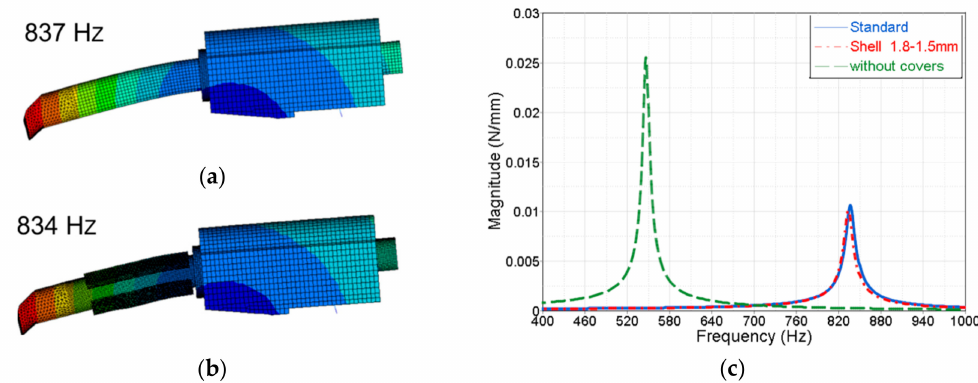
Figure 17. ( a ) Original boring bar dominant mode, ( b ) active boring bar dominant mode and ( c ) comparison between original (i.e., standard) and active boring bar in terms of